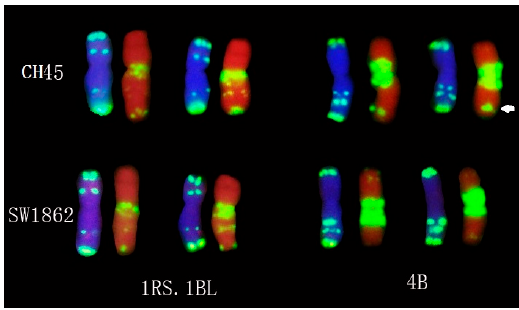
Figure 5. FISH karyotype of chromosomes 1RS.1BL and 4B in SW1862 and CH45. Left chromosomes were stained with DAPI (blue), Oligo-pTa535 (red), and Oligo-pSc119.2 (green), while right chromosomes were stained by PI (red) and Oligo-(GAA) 7 (green). Arrow shows the unique hybridization on 4B of CH45.